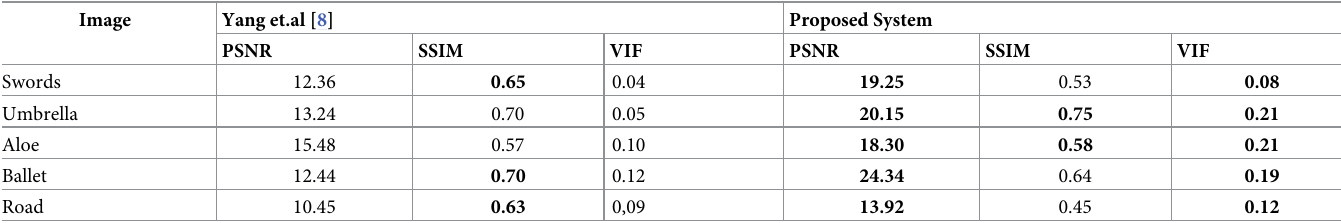
Table 3. Comparison parameters PSNR, SSIM and VIF using dataset